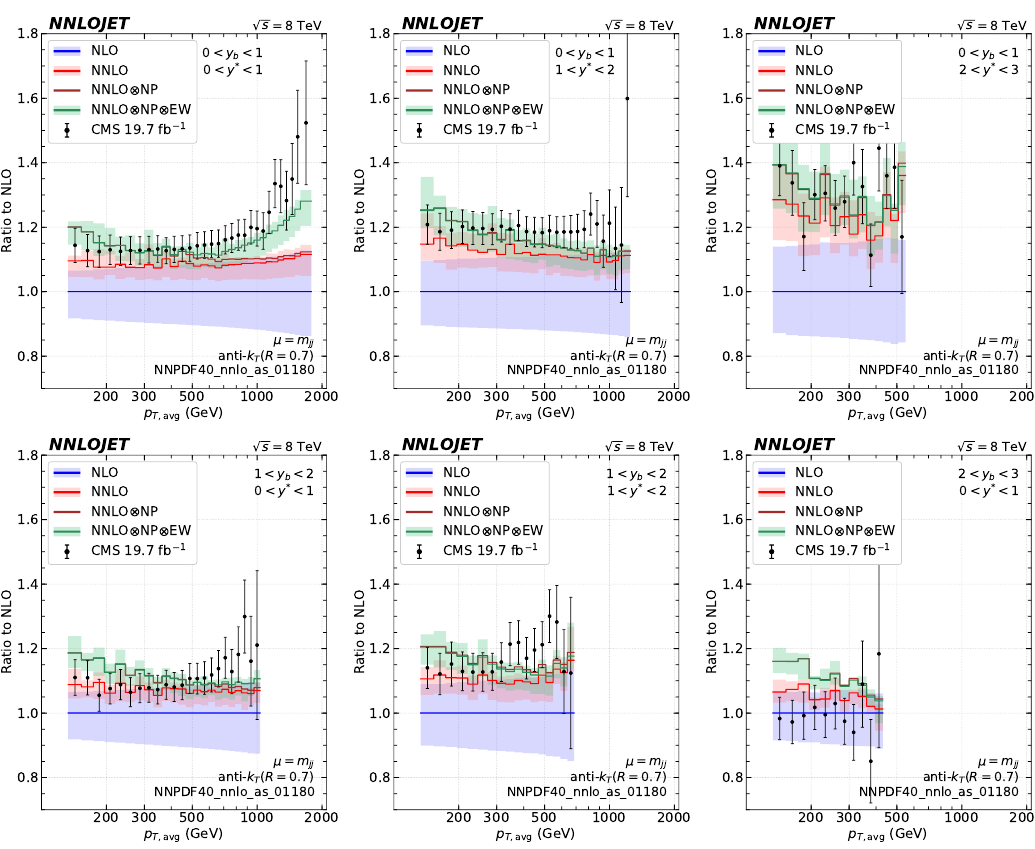
Figure 12 . The triply differential dijet cross section as function of the average transverse momen- tum p T, avg for all the considered regions in rapidity separation y ∗ and dijet system boost y b space with R = 0 . 7 anti- k T jets compared to the CMS 8 TeV data [90] normalized to the NLO prediction. at LO with the NNPDF40_nnlo_pdfas set. We find the α low p region. The combined uncertainties range from ± 1 . 3% to 1 . 7% at low p T, avg